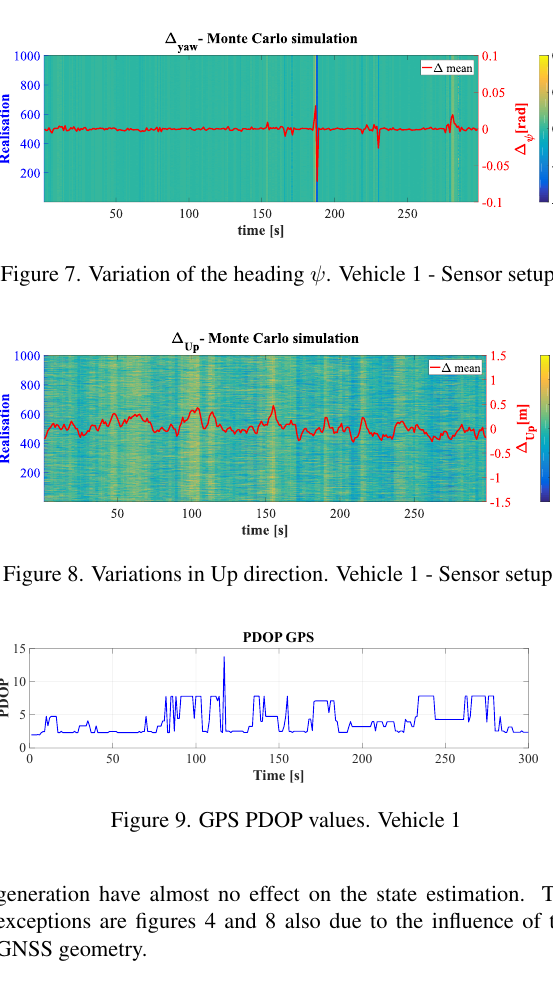
Figure 6. Deviation in lateral (top panel) and longitudinal (bottom panel) directions. Vehicle 1 - Sensor setup 1